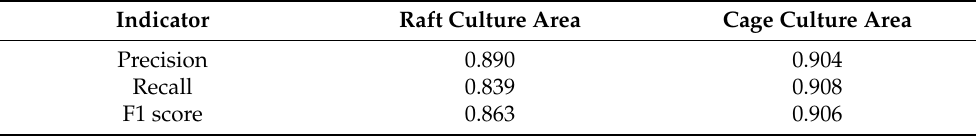
Table 2. Precision, recall, and F1 score of test samples in two types of aquaculture area. Indicator Raft Culture Area Cage Culture Area